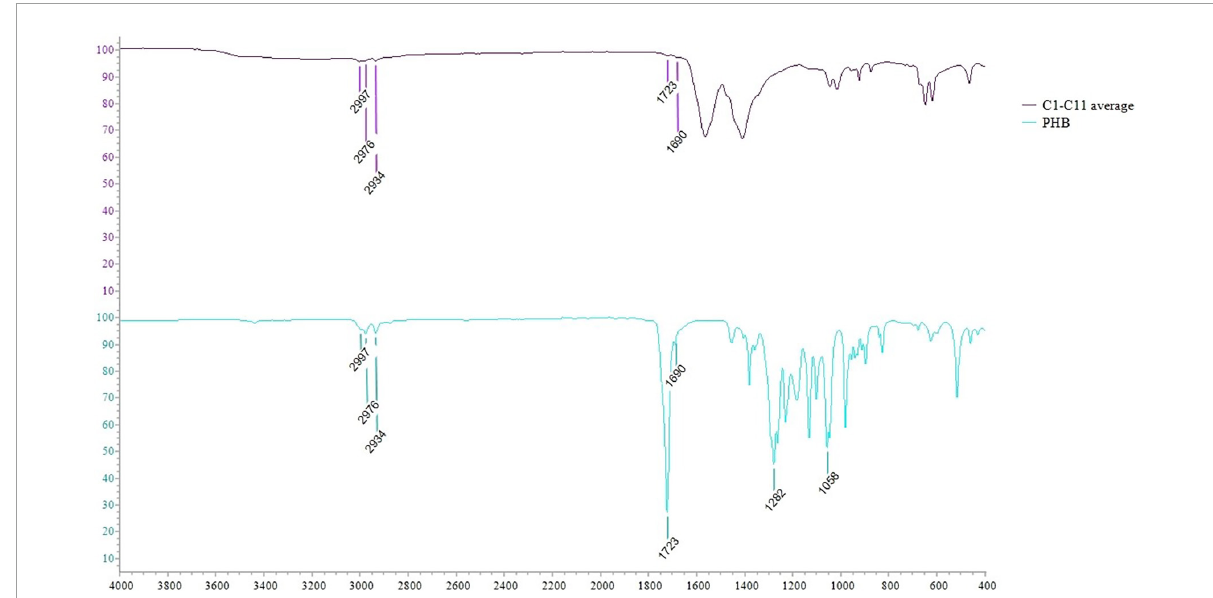
FIGURE7 ATR-FTIR spectra comparison between the average spectrum obtained for C1–C11 isolates with that obtained for PHB pure standard.